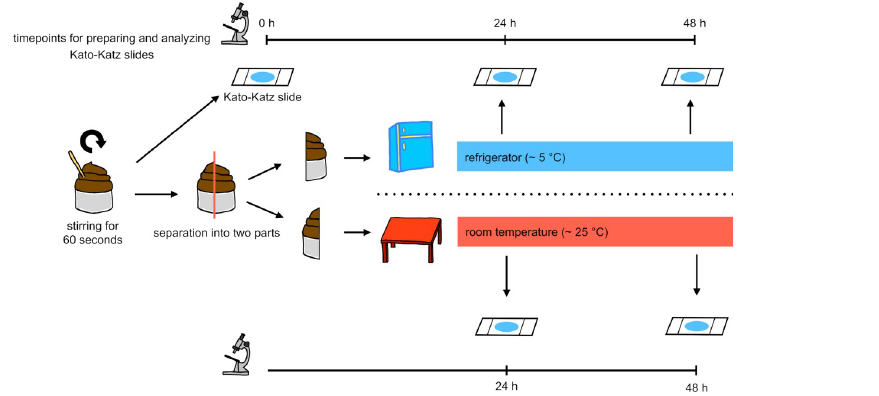
Fig 2. Procedure of the whole sample storing